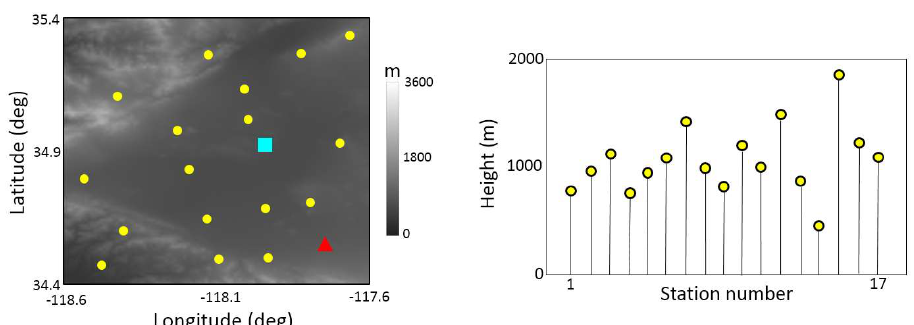
Figure 5. Topography of the study area and the distribution of the Global Positioning System (GPS) stations. The blue square represents the radiosonde station and the red triangle shows the position of the station used to evaluate the results.